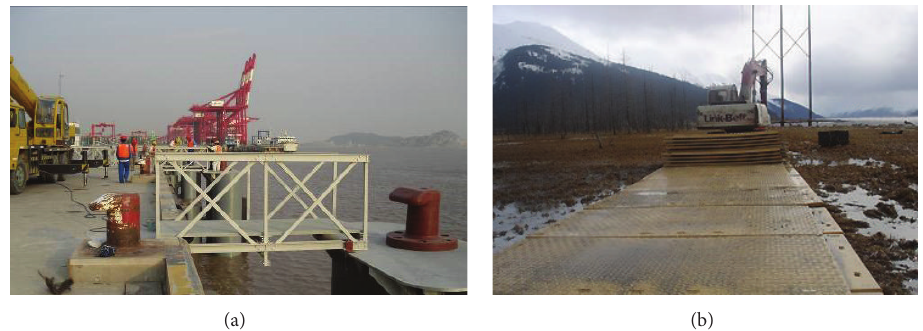
Figure 2: Practical applications of GFFW decks: (a) a truss bridge with GFFW decks and (b) GFFW bridge decks used as the backing board.